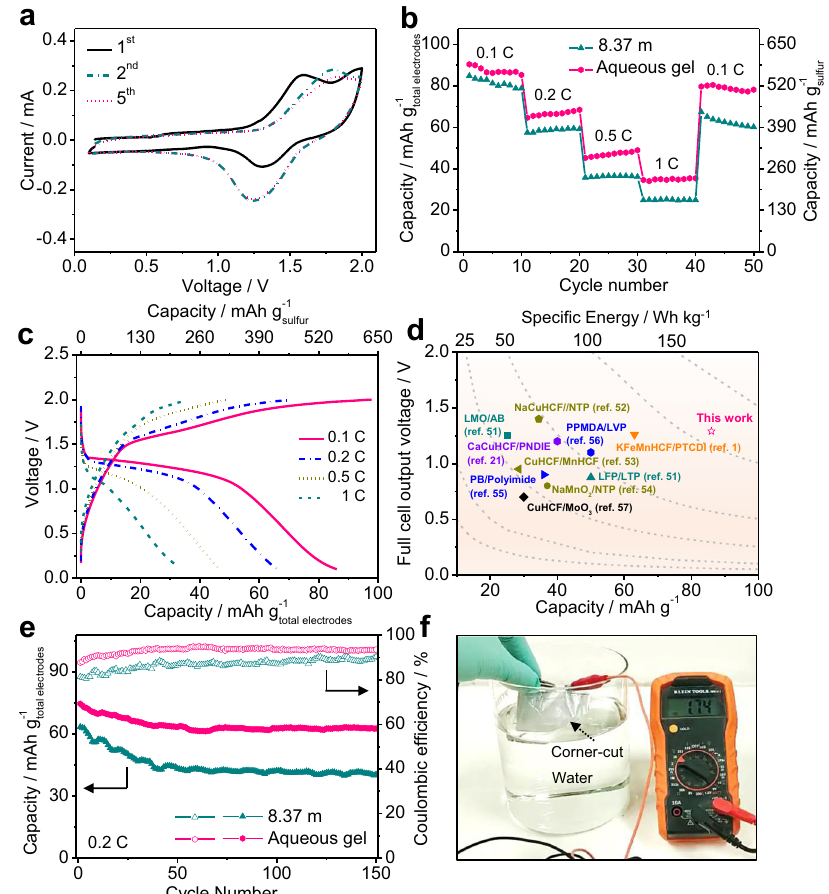
Fig. 5 The electrochemical performances of the as – assembled ACSBs. a The CV curves of the S/C|aqueous gel electrolyte|Ca 0.4 MnO 2 full cell collected at a scan rate of 0.2 mV s – 1 . b The rate performance of full cells with different electrolytes. c The voltage pro fi les of full cell assembled with aqueous gel electrolyte at different speci fi c currents. d Comparison of speci fi c energies of various aqueous energy storage devices based on the total mass of the electrode active materials. Color code: cyan, brown, orange, blue, black, and violet represent Li – , Na – , K – , Mg – , Al – , Ca – based aqueous batteries, respectively. e The cycling performances and corresponding Coulombic ef fi ciencies of S/C||Ca 0.4 MnO 2 full cells at 0.2 C. The mass ratio of Ca 0.4 MnO 2 cathode to S/C anode is about 1.6:1. f Water – soaking test of charged S/C|aqueous gel electrolyte|Ca 0.4 MnO 2 pouch cell after corner 93%. These values are much higher than those of the cell with saturated Ca(NO 3 ) 2 aqueous electrolyte (65 and 86%) due to the immobilization of calcium polysul fi des by PVA. Single-layer S/C | aqueous gel electrolyte|Ca 0.4 MnO 2 pouch cells were also